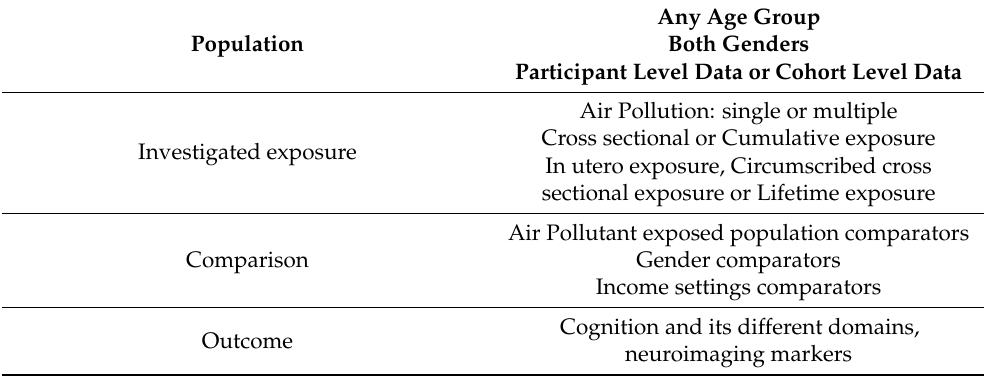
Table 1. The Population, Investigated Exposure, Comparison, Outcome (PICO) Framework for Research